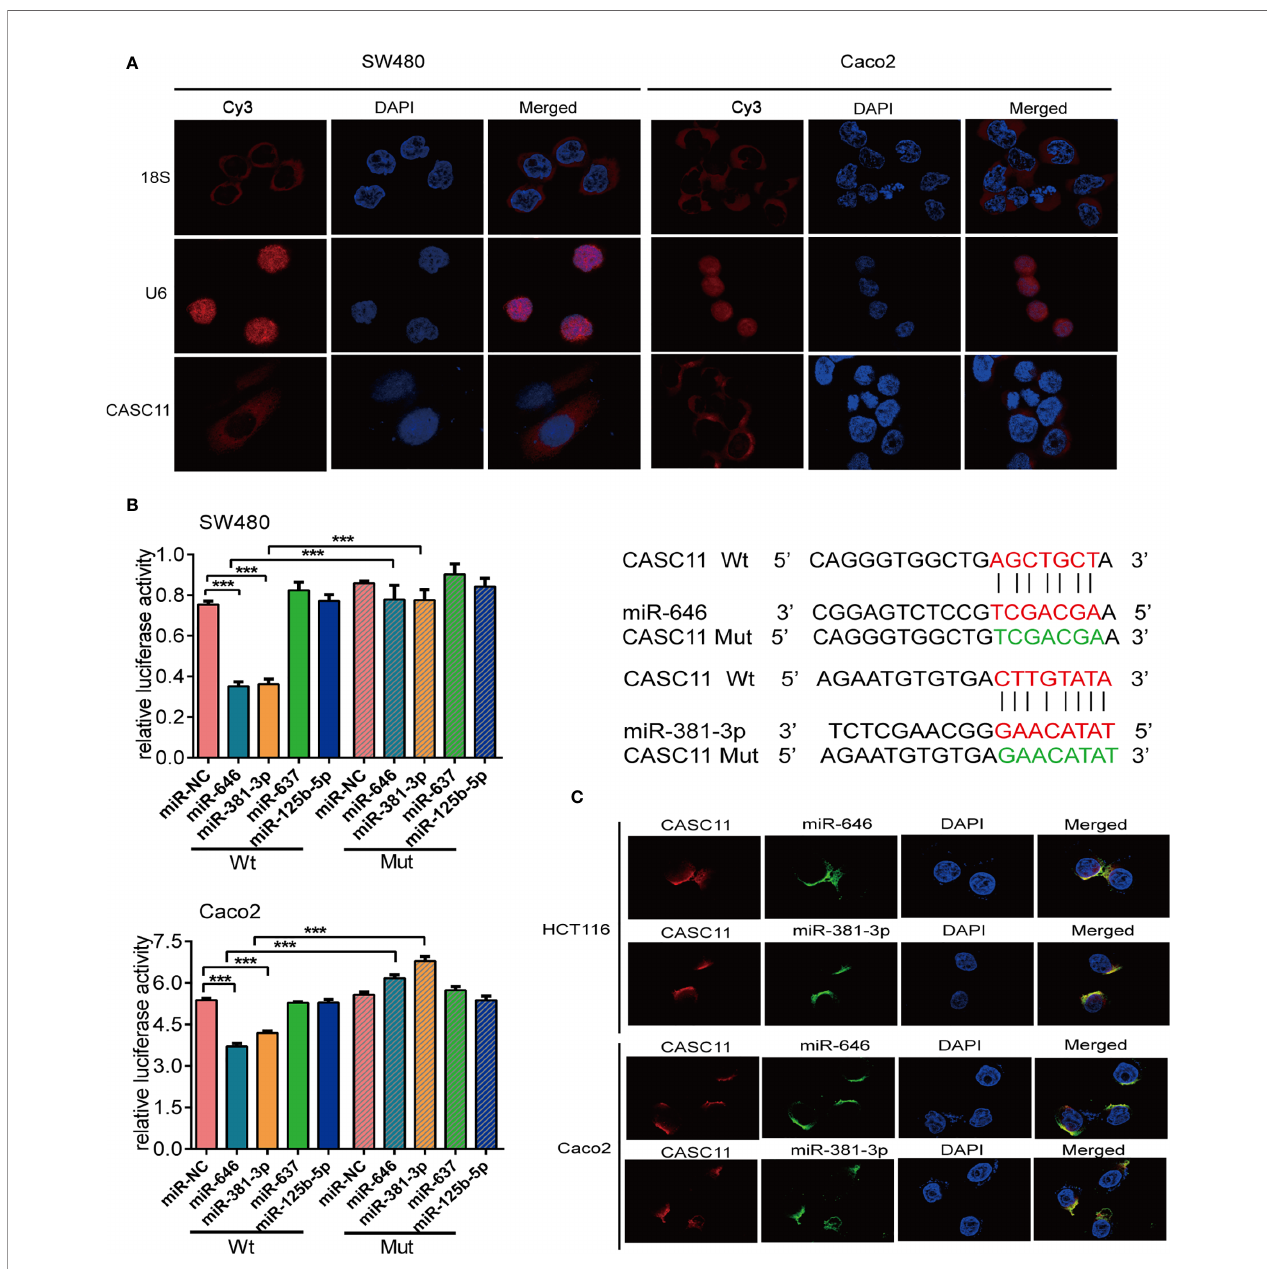
FIGURE 1 | miR-646 and miR-381-3p bind to CASC11 in the cytoplasm. (A) Representative fl uorescence images of the subcellular localization of CASC11. U6 and 18S were used as positive controls for the nucleus and cytoplasm, respectively. (B) The relative luciferase activity of SW480 and Caco2 cells was tested after co- transfection with wild-type or mutant CASC11 and miRNA mimics. Sequence alignment of miR-646 and miR-381-3p with the binding sites in the wild-type and mutant regions of CASC11 were shown on the right side. Error bars represent the means ± SD of 3 independent experiments. *** p <0.001. (C) FISH demonstrated that CASC11 colocalized with miR-646 and miR-381-3p in the cytoplasm of HCT116 and Caco2 cells. Red: CASC11 probes were labelled with Cy3. Green: miR- 646 and miR-381-3p probes were labelled with FITC. Blue: nuclei were stained with 4 ’ ,6-diamidino-2-phenylindole